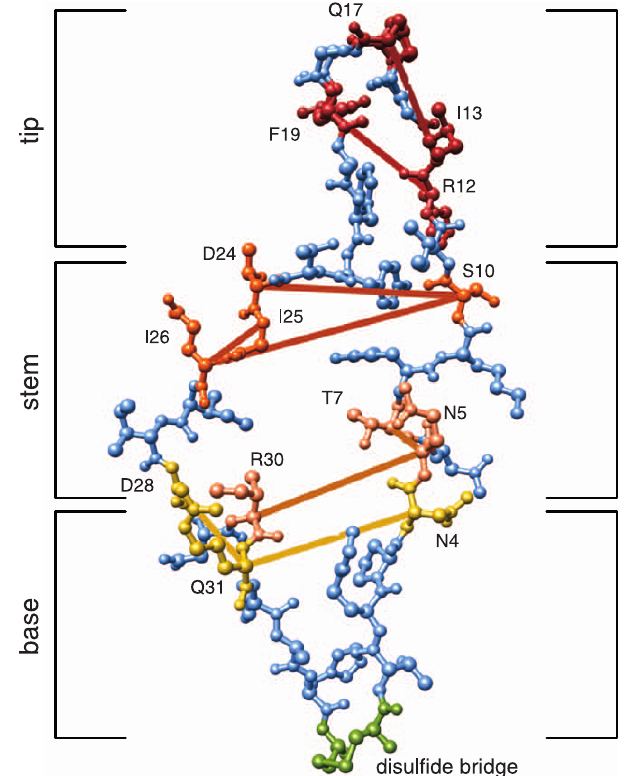
Figure 4. Structural Model of the V3 Loop A three-dimensional visualization of the structure of the V3 loop, using structural coordinates from a model comprised of the HIV-1 gp120 core protein complexed to the CD4 receptor and the X5 antibody [28]. The structure is oriented such that the host cell membrane would be positioned at the top of the figure. The cysteine residues forming a disulfide bridge that closes the loop are labeled in green. The amino acid sequence depicted here differs from our consensus sequence at five positions, such that identity would require the following substitutions: Q5N, H12R, R17Q, T21A, and E24D.